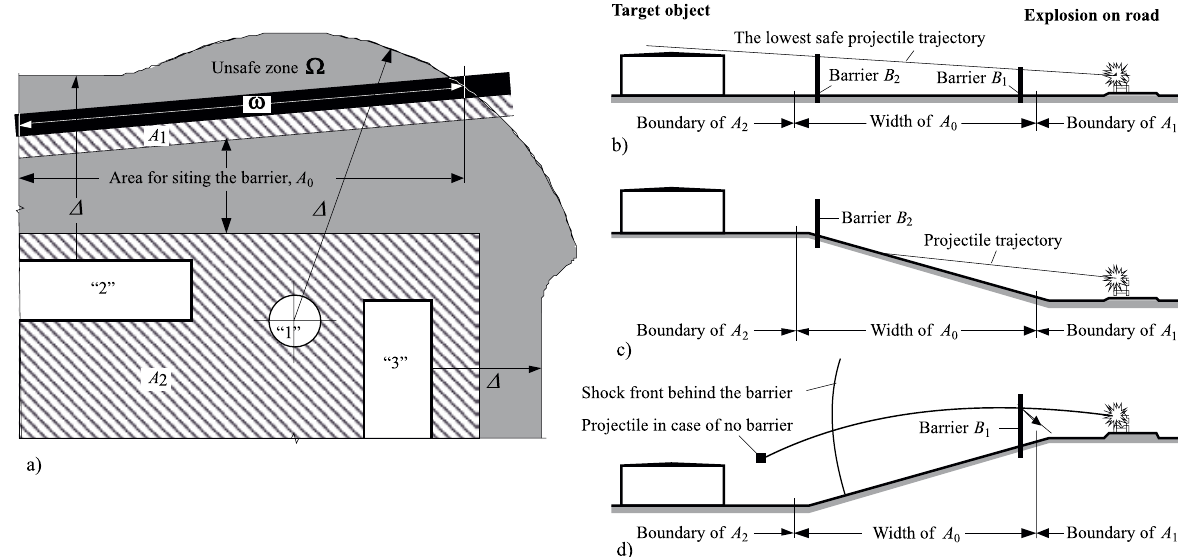
Fig. 2. The area A 0 available for sitting the barrier between road and target object(s): a – A 0 formed by the unsafe zone with irregular shape around the target objects “1” to “3” and the areas A 1 and A 2 in which a barrier construction is prohibited; b – the choice between two barriers in a flat horizontal area A 0 ; c and d – sitting the barrier by tanking into account the influence of the relief on attenuation or strengthening of explosion